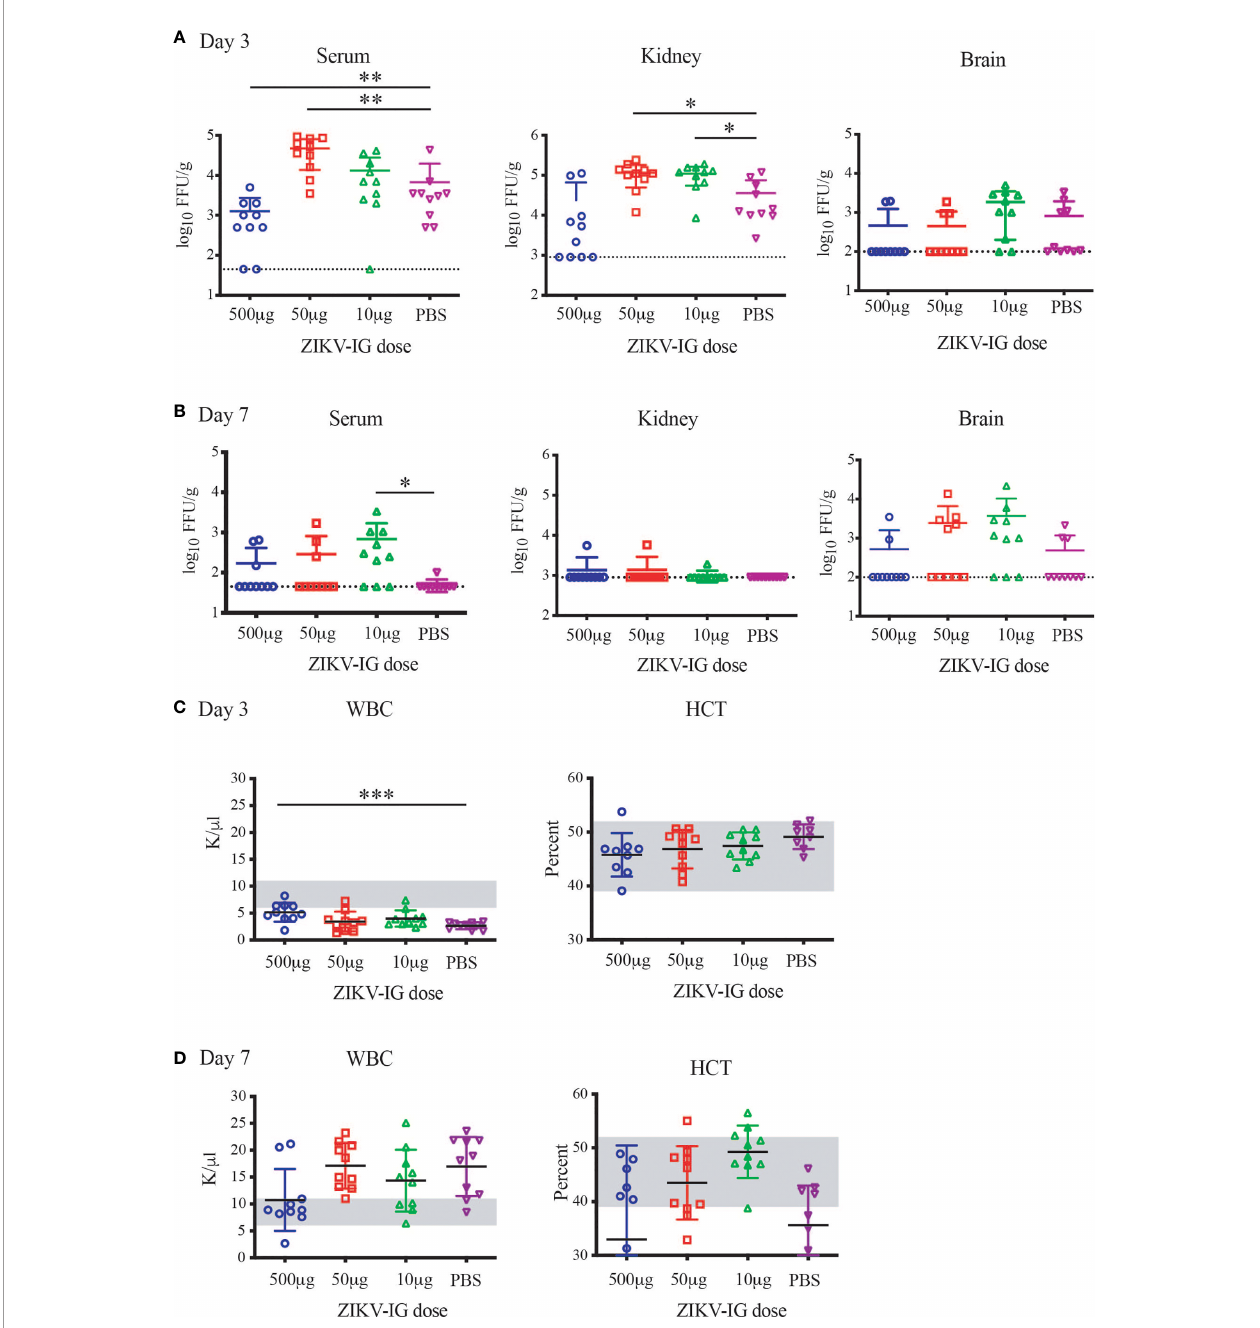
FIGURE 7 | Alterations in Viral Replication and hematology from protective versus enhancing doses of ZIKV-IG. Ifnar -/- mice were infected with ZIKV (10 5 FFU) via an intravenous route. Ifnar -/- mice were pre-treated with a protective concentration of ZIKV-IG (0.500 mg/mouse) or enhancing amounts of ZIKV-IG (0.050 and 0.010 mg of ZIKV-IG). Levels of virus were determined from samples harvested 3 days (A) or 7 days (B) after infection FFA. Data are shown as log 10 FFU/ ml for serum or log 10 FFU/g for organs from n = 10 mice (5 male and 5 female) per condition. The dotted line represents the limit of sensitivity of the assay and error bars indicate SD. Asterisks indicate values that are statistically signi fi cant compared to PBS treated mice. White blood cell counts and hematocrit were evaluated at days 3 and 7 (C, D) . The grey region is the normal range of male and female C57BL/6 mice of the same age. Viral titer was evaluated by Mann Whitney *p < 0.05, **p < 0.005, ***p <